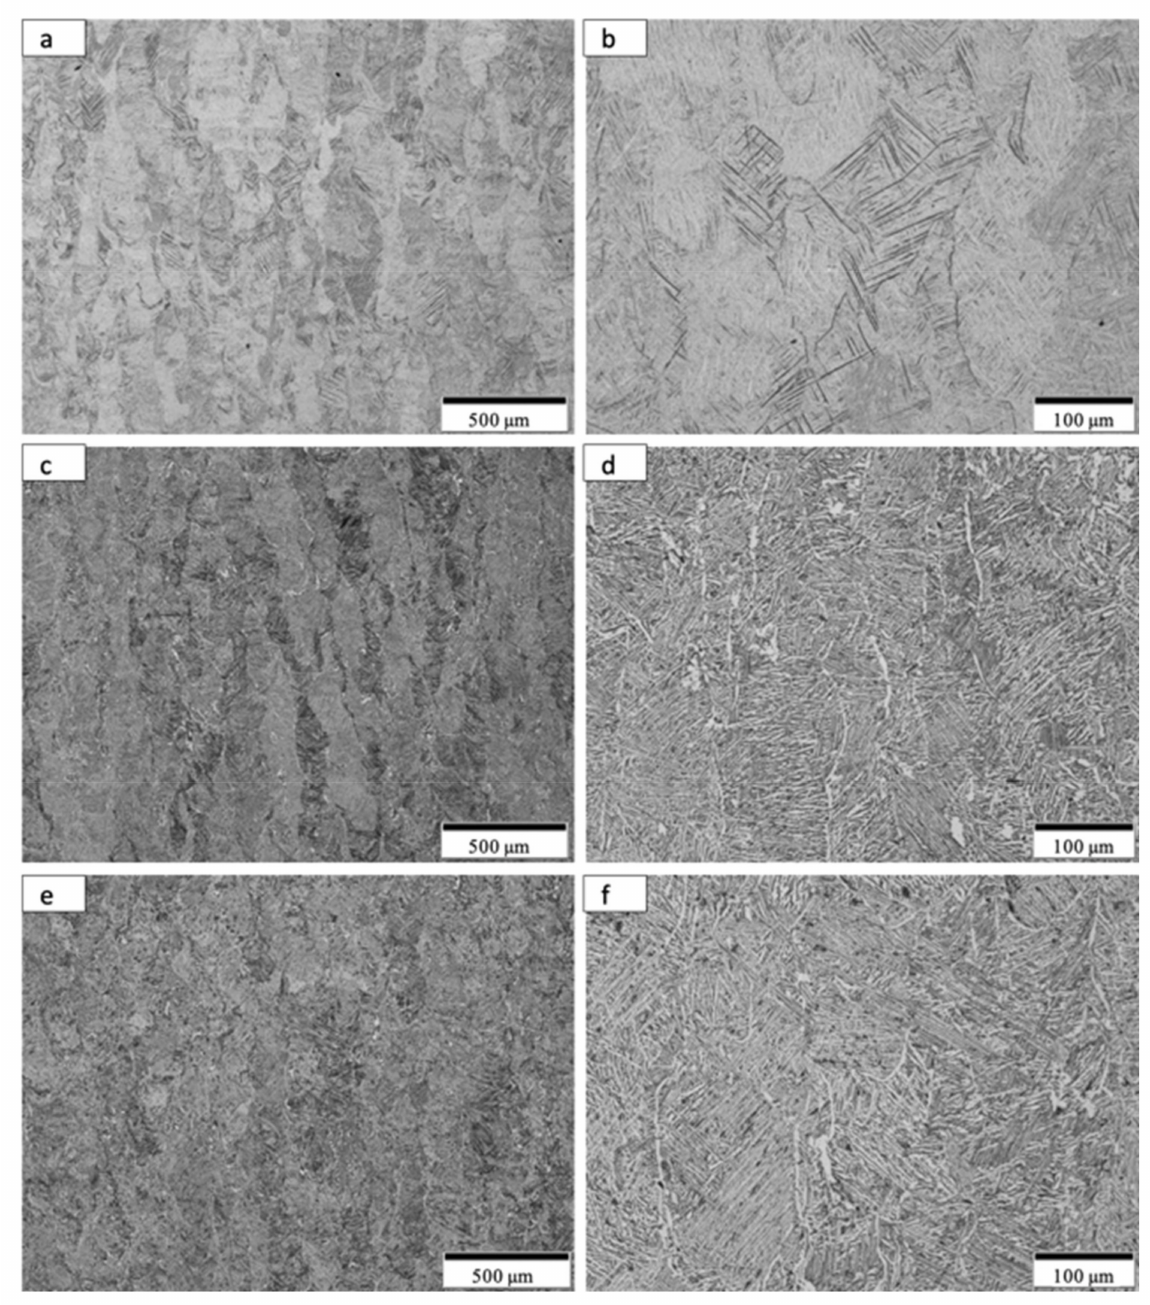
Figure 9. Optical micrographs for Anneal, HIP and HIP + Anneal samples from the build bottom. ( a , b ) show low and high magnification images for anneal samples. ( c , d ) show low and high magnification images for HIP samples. ( e , f ) show low and high magnification image for HIP + Anneal